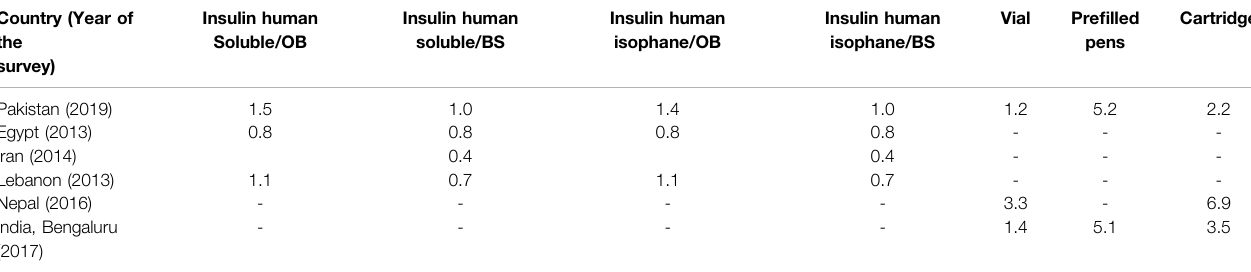
TABLE 7 | International comparison of affordability of insulin products for a least-paid unskilled public servant in terms of number of days ’ wages required to obtain a 30- day dose. Country (Year of Insulin human the survey)